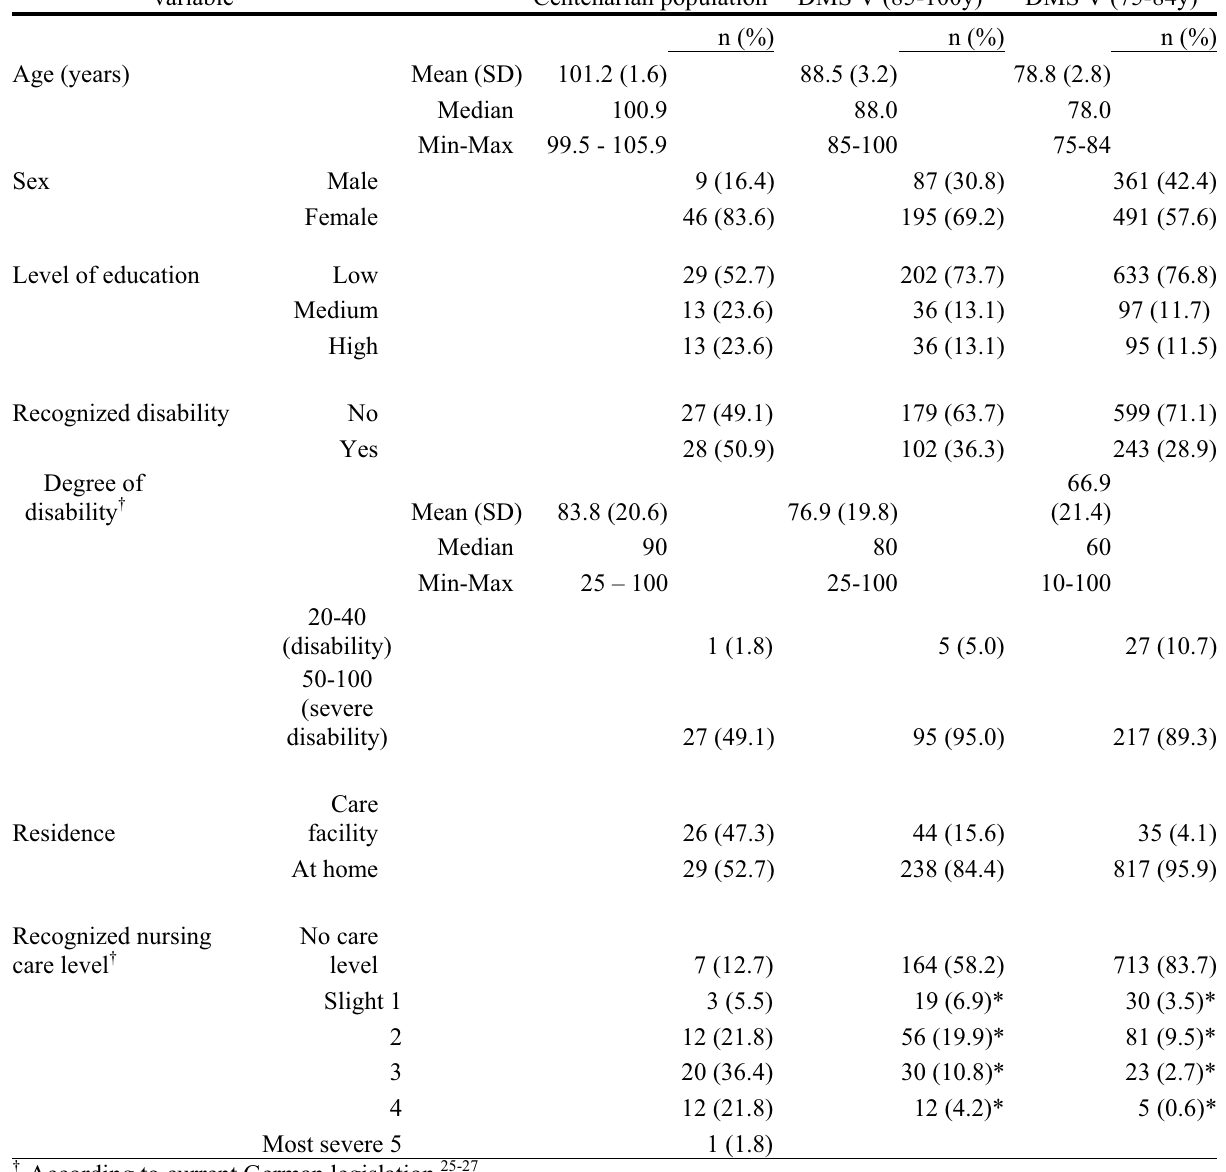
Table 1. Characteristics of study